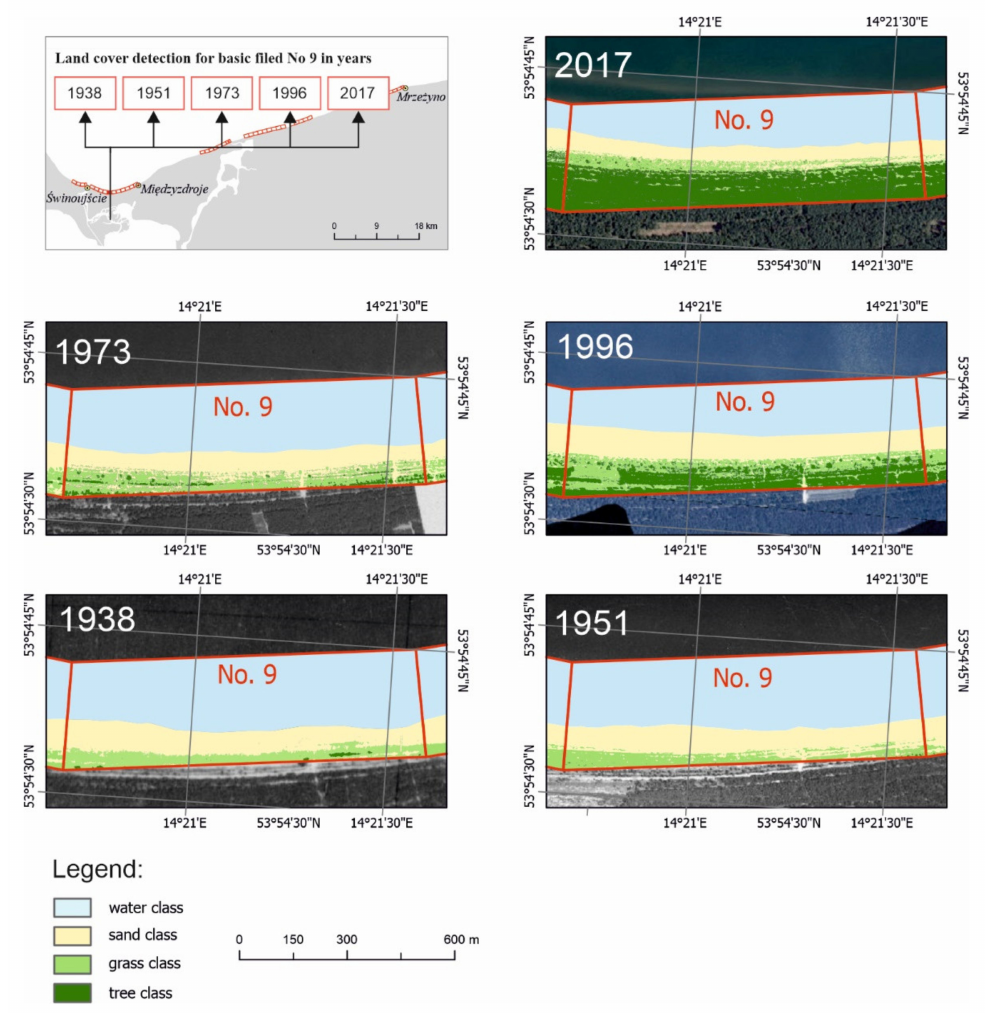
Figure 3. An example of land cover detection for basic field no.